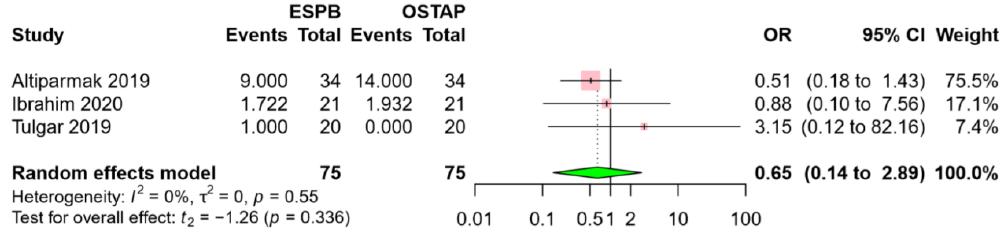
Figure 8. Forest plot for postoperative nausea and vomiting. The incidence of PONV was similar between the ESPB group and the OSTAP group. Abbreviations: ESPB, erector spinae plane block; OSTAP, oblique subcostal transversus abdominis plane block; OR, odds ratio; CI, confidence interval.